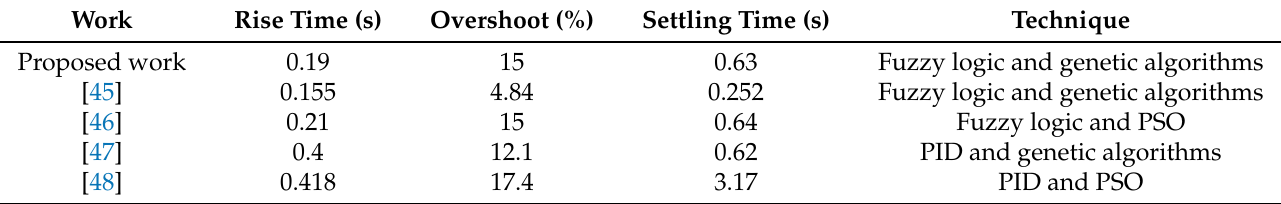
Table 3. Comparison of controller performance with previous